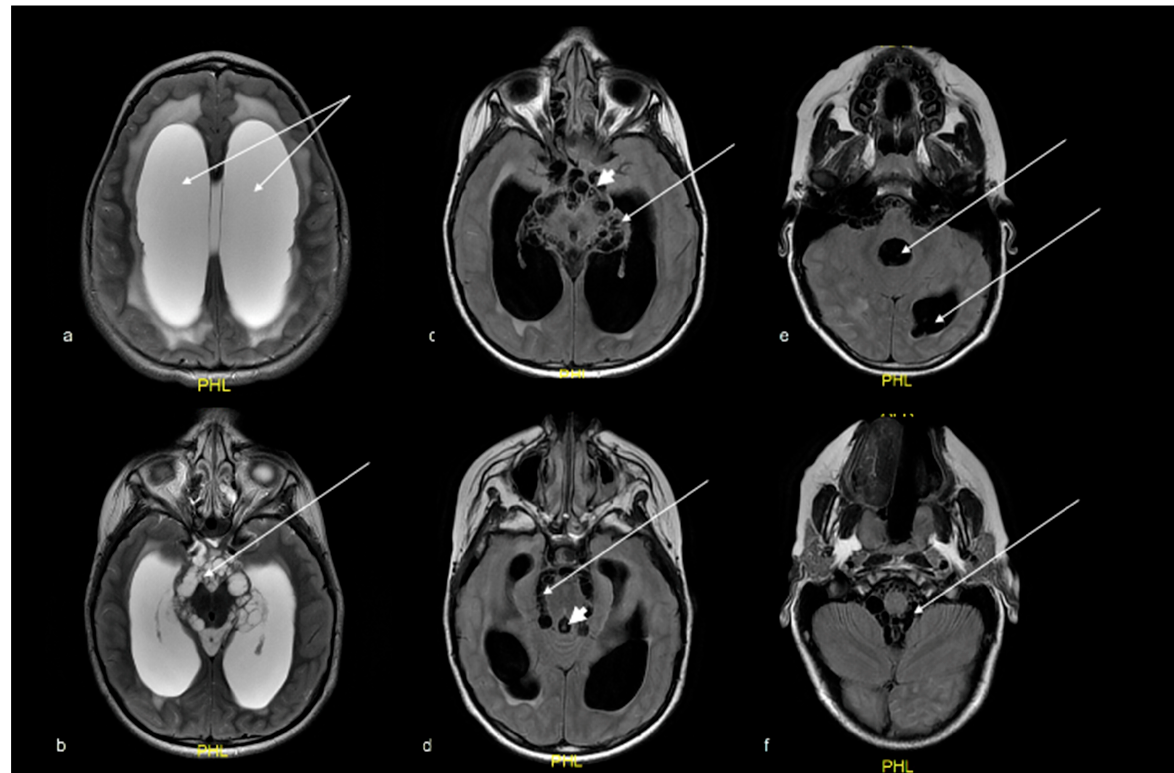
Figure 1. ( a ) T2 axial MRI brain demonstrates dilated lateral ventricles (arrows) with transependymal oedema in keeping with acute hydrocephalus. ( b ) T2 axial MRI and ( c – f ) FLAIR axial MRI brain demonstrates multiple cysts (arrows) in the basal cisterns, cerebellomedullary cistern, pontomedullary cistern, fourth ventricle and left posterior horn of lateral ventricle. Some cysts demonstrated a central dot in keeping with a scolex of NCC